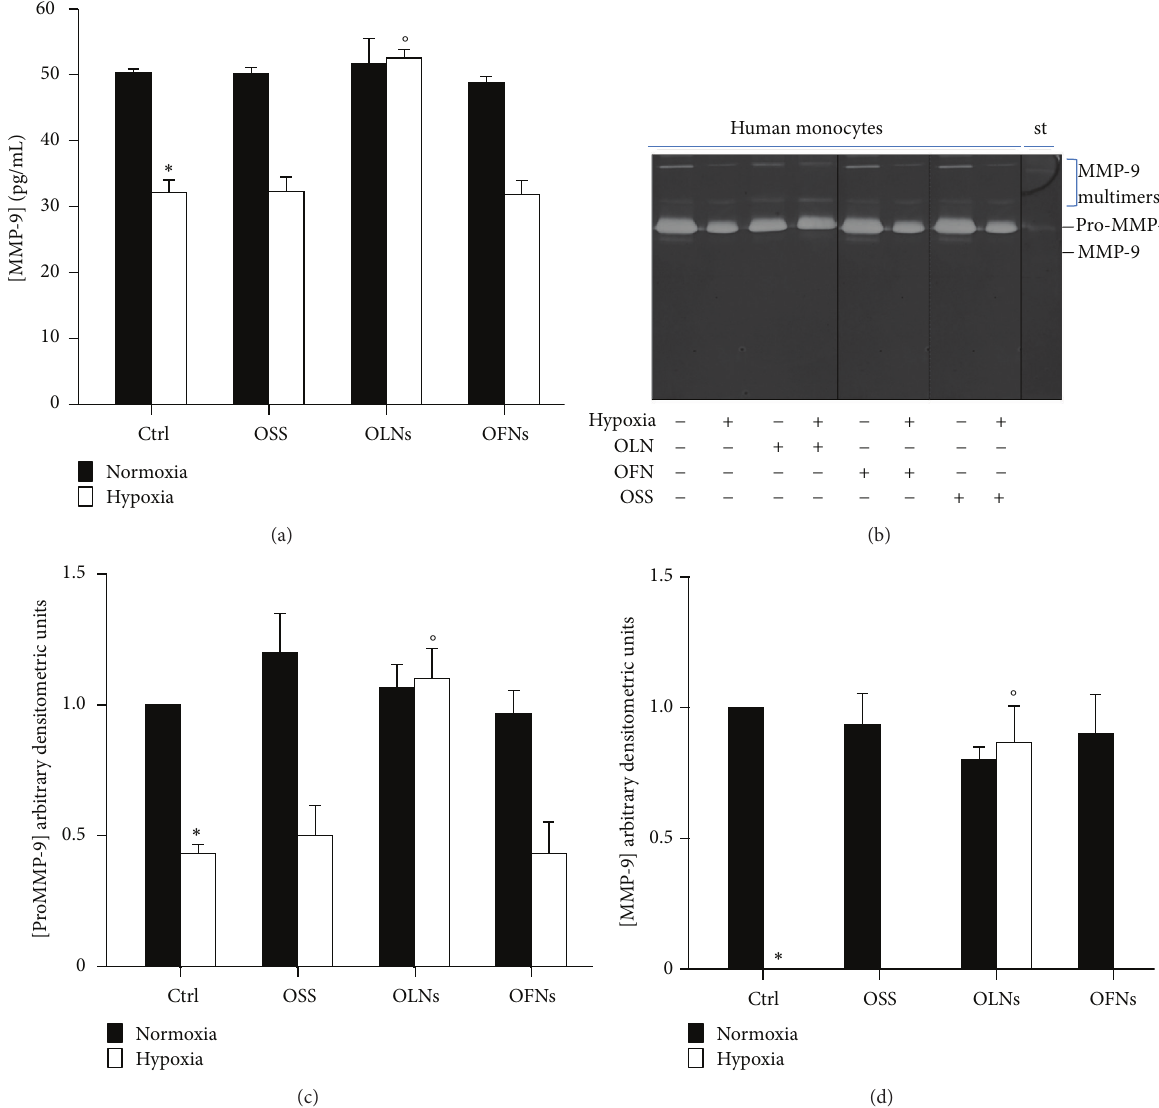
Figure 3: Hypoxia and OLN effects on MMP-9 secretion by human monocytes. Human adherent monocytes (10 6 cells/2 mL Panserin 601 medium) were left untreated or treated with 200 𝜇 L OLNs, OFNs, or OSS for 24 h in normoxia (20% O 2 ; panels (a), (c), and (d): black columns; panel (b): odd lanes) or hypoxia (1% O 2 ; panels (a), (c), and (d): white columns; panel (b): even lanes). After collection of cell supernatants, MMP-9 protein levels were quantified by ELISA (panel (a)), whereas MMP-9 latent/active forms were analyzed by gelatin zymography (panel (b)) and subsequent densitometry (panels (c)-(d)). For gelatin zymography, recombinant human MMP-9 (83kDa) was employed as a standard marker (st). Results are shown as means + SEM (panels (a), (c)-(d)) or as a representative gel (panel (b)) from three independent experiments. ELISA and densitometric data were also evaluated for significance by ANOVA: ∗ versus normoxic control cells: 𝑃 < 0.0001 (panel (a)), 𝑃 < 0.02 (panel (c)), and 𝑃 < 0.0001 (panel (d)); ∘ versus hypoxic control cells: 𝑃 < 0.0001 (panel (b)), 𝑃 < 0.005 (panel (c)), and 𝑃 < 0.0001 (panel